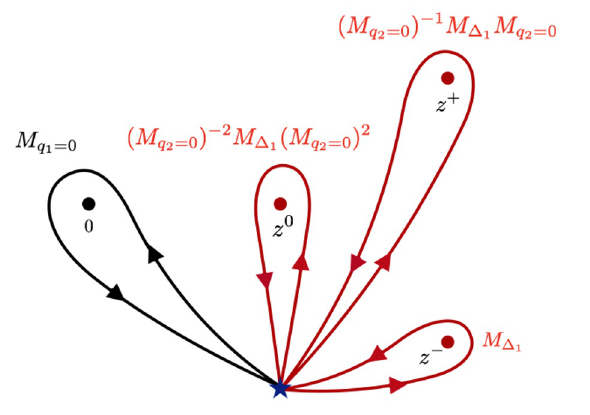
Figure 4. Positions of the regulator strings for the charge e = (1 , 0) , for 1 / 432 (cid:29) | ¯ q 1 | > 0 and 1 / 27 (cid:29) | ¯ q 2 | > 0 together with the monodromies around them as measured along a loop encircling the strings